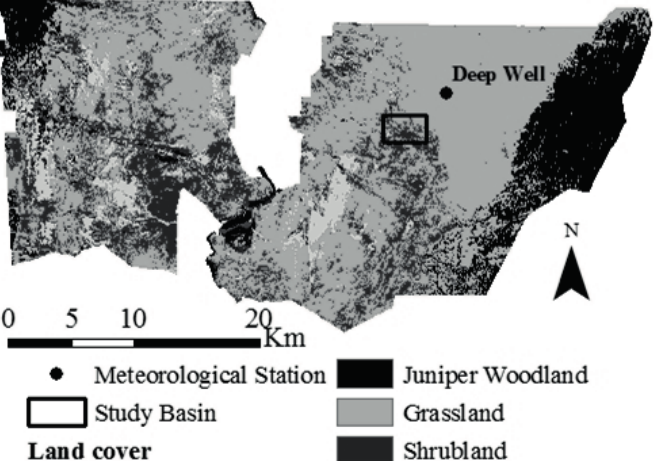
Fig. 1 Study site in central New Mexico: the land cover map of the SNWR, overlain by the watershed boundary of the study site and the Deep Well meteorological